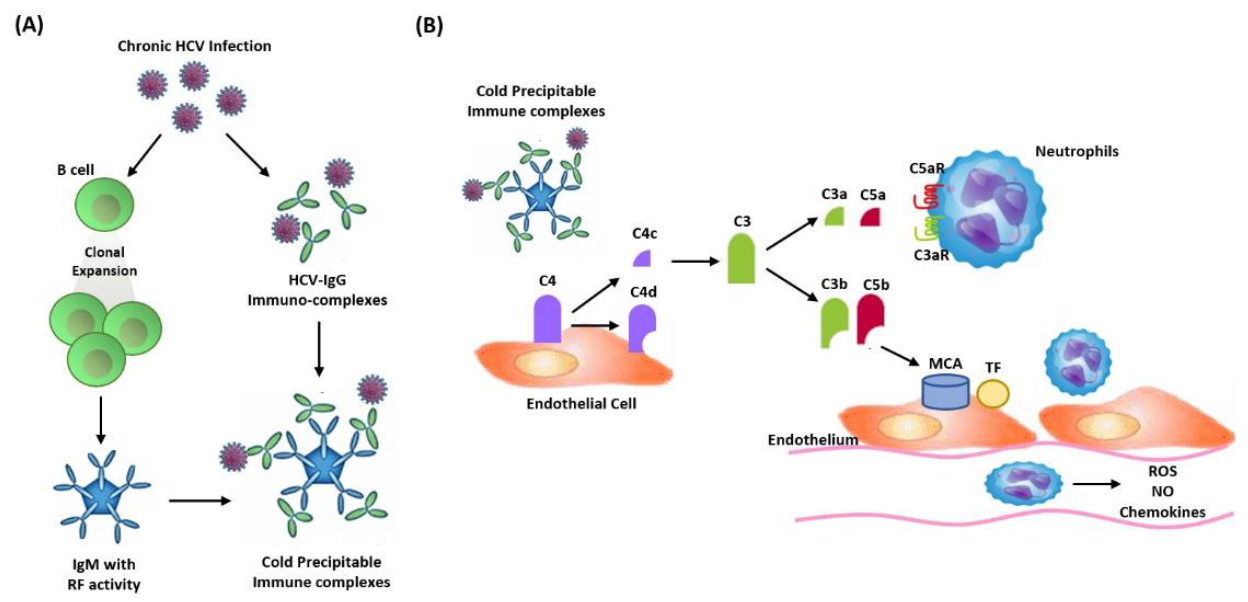
Figure 2. Molecular mechanisms of HCV-associated cryoglobulinemic glomerulonephritis. ( A ) B cell activation during acute and chronic HCV infection, which then leads to polyclonal activation and expansion of B cells producing monoclonal IgM rheumatoid factor (RF). Monoclonal IgMs that are known to display RF activity, favoring the formation of cold-precipitable immune complexes formed by the monoclonal IgM itself, HCV, and anti-HCV polyclonal IgG antibodies, which are responsible for glomerulonephritis. ( B ) The classical complement pathway is activated when the cold-precipitable immune complexes are deposited in the mesangial and subendothelial space in the kidney. When complement component C4 is cleaved by cold-precipitable immune complexes, it forms two fragments, C4a and C4b. This then results in the downstream formation of C3 and C5 convertases. C3a and C5a activate the complement cascade via C3aR and C5aR, which amplifies the inflammatory response by activating neutrophils. The interaction of the membrane attack complex (MAC) with C3b and C5b enhances tissue factor (TF) expression in endothelial cells (ECs) of the kidney and can further promote proinflammatory EC activation.